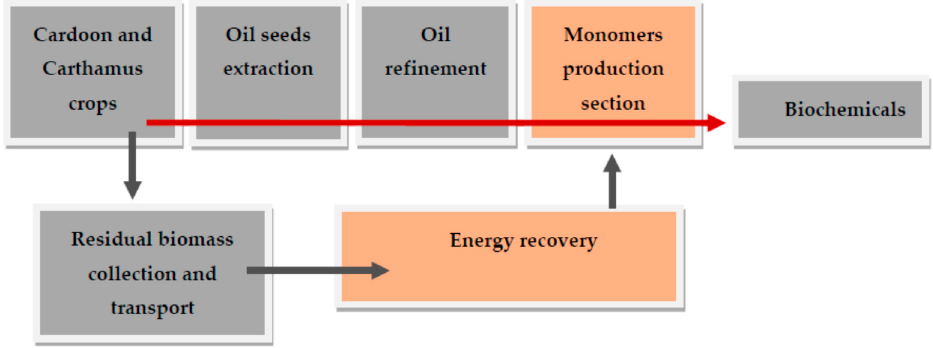
Figure 1. Biorefinery concept: seed path (in red) and residual stock path (grey).